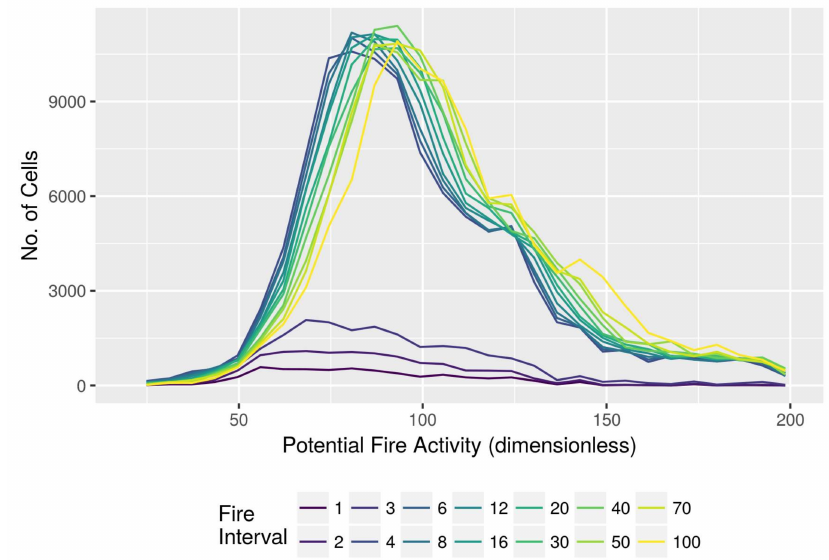
Figure 7. Impact of fire interval on future Potential Fire Activity across Tasmania.